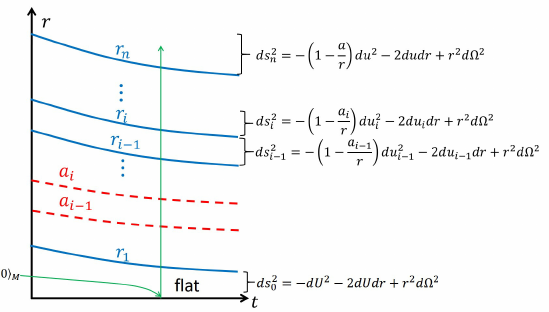
Figure 8. A multi-shell model, which models the time evolution of the matter depicted by the left in Figure